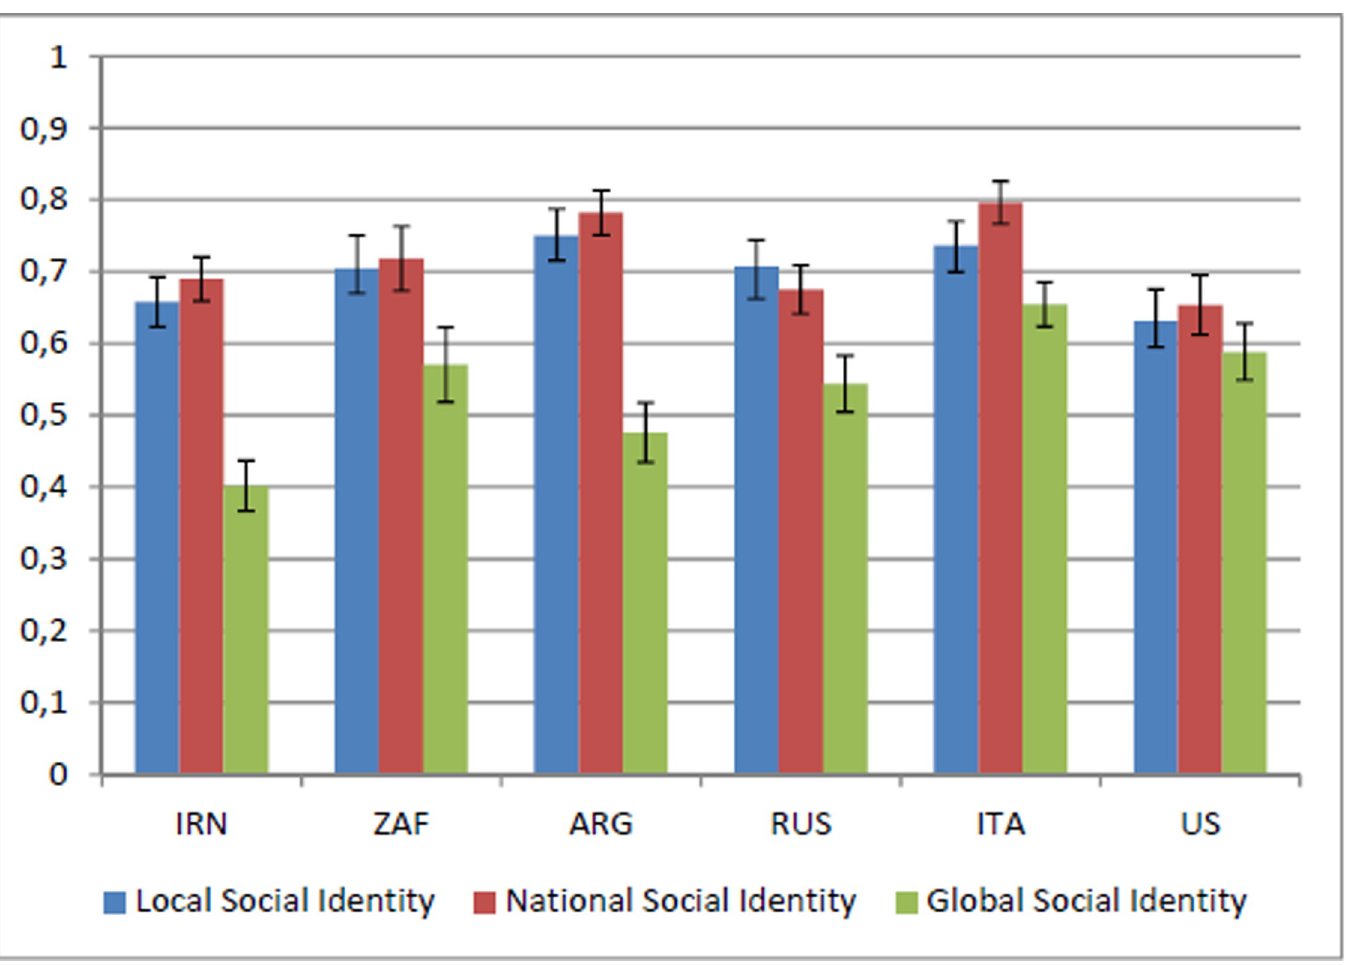
Fig 3. Average levels of local, national, and global social identity, per country. Descriptive statistics for the whole sample are reported in Table E in the S1